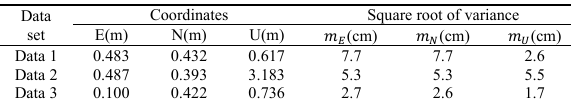
Table 4 . Calculate with sound speed